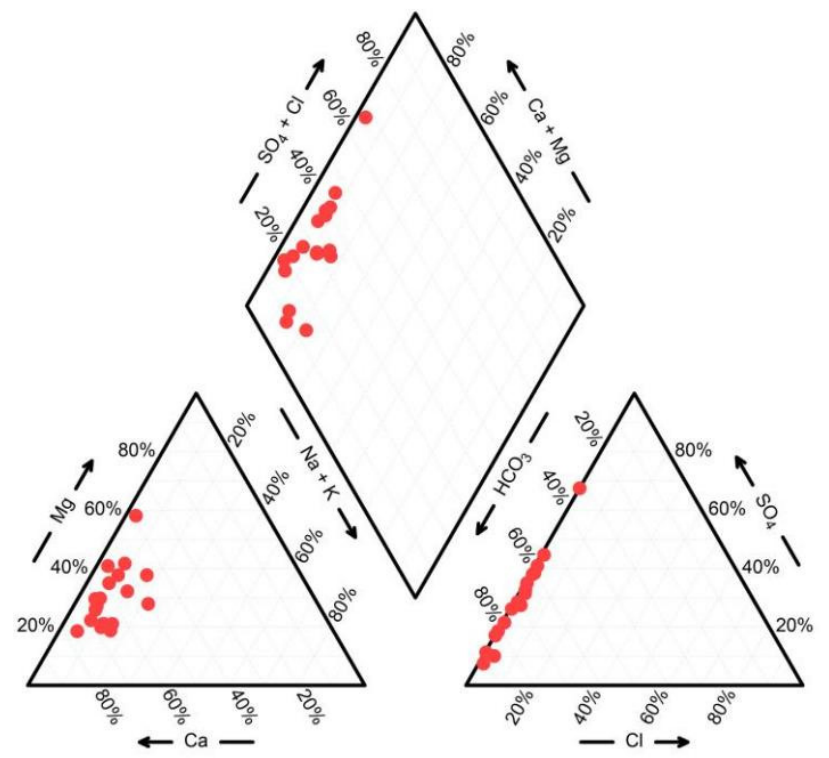
Figure 3. Piper diagram of natural water chemistry.